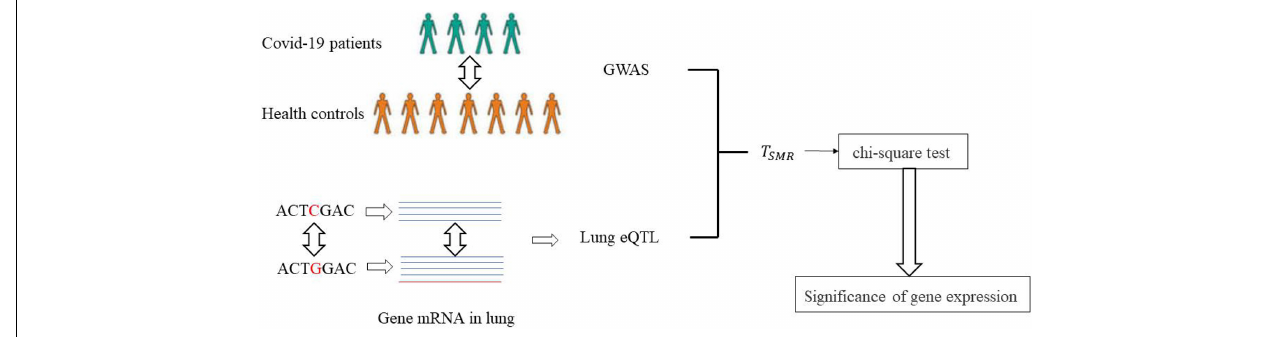
FIGURE 3 | The workflow of identifying causal genes of COVID-19 using the SMR method.